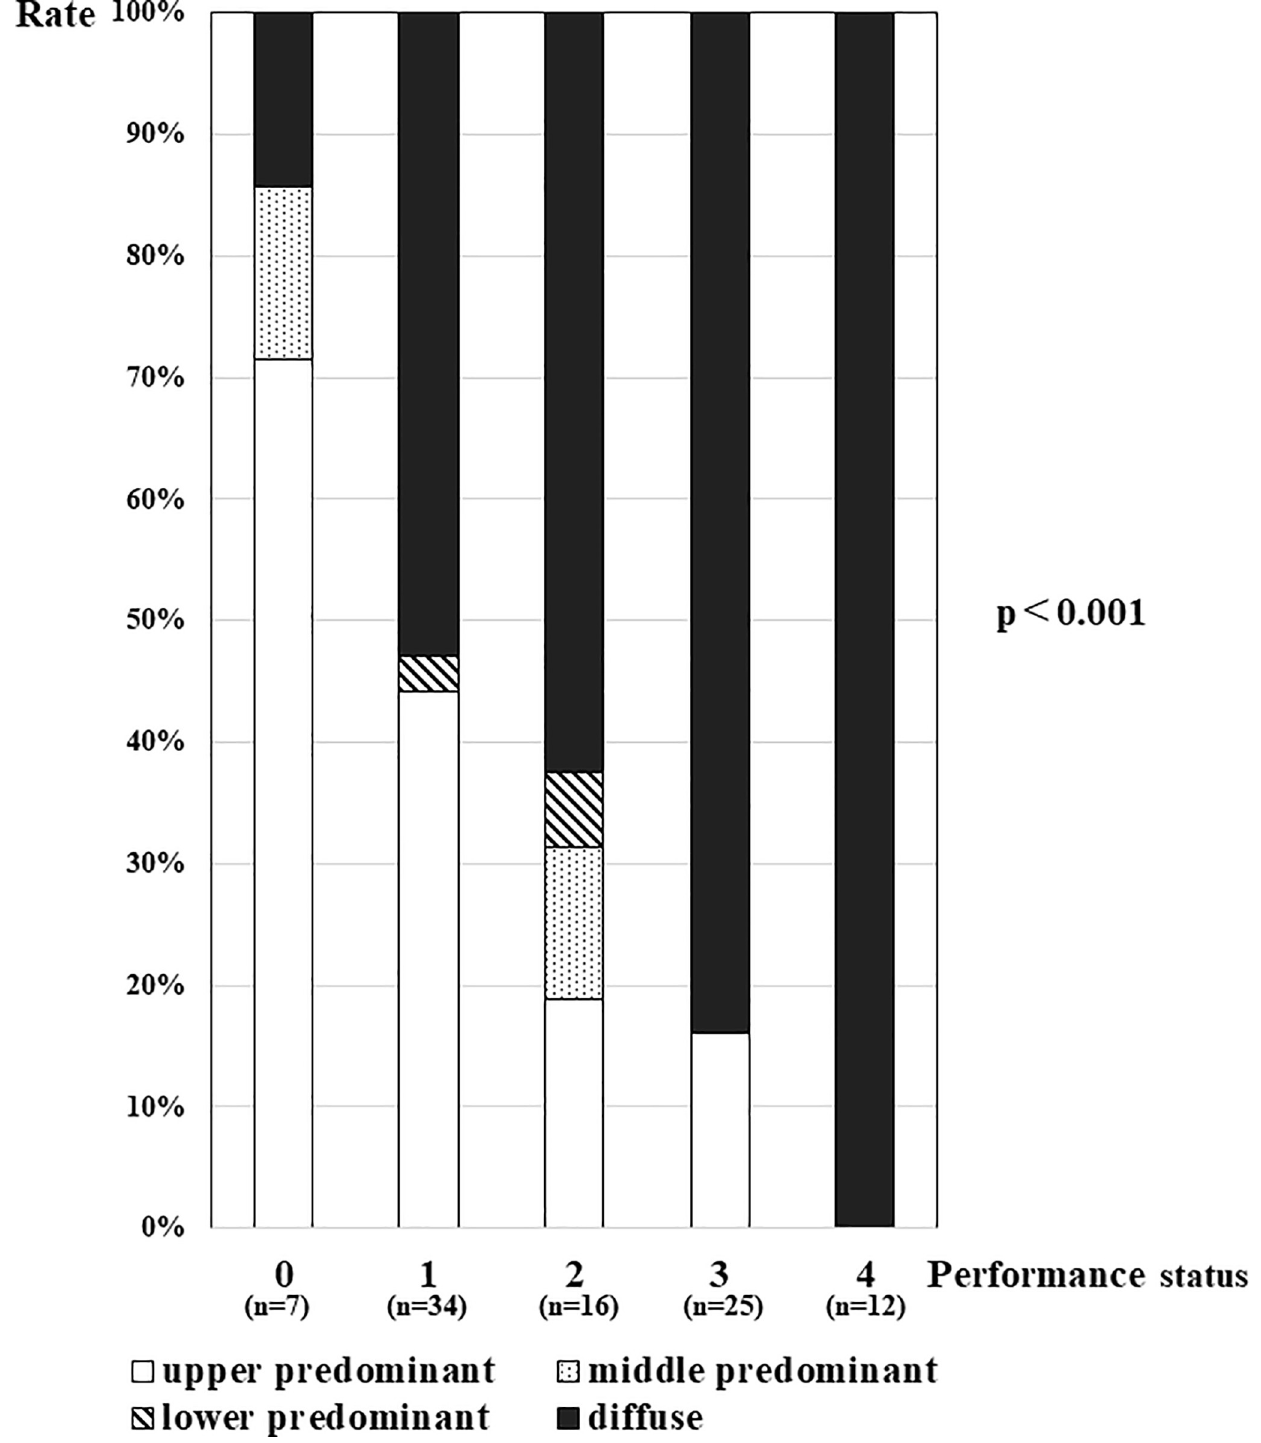
Fig 2. The relationship between performance status and lung distribution in patients with pulmonary tuberculosis. Upper predominant distributions were seen in 71% in PS0, 44% in PS1, 19% in PS2, 16% in PS3, and 0% in PS4; middle predominant distributions were seen in 14% in PS0, 0% in PS1, 13% in PS2, 0% in PS3, and 0% in PS4; lower predominant distributions were seen in 0% in PS0, 2.9% in PS1, 6.3% in PS2, 0% in PS3, and 0% in PS4; and diffuse distributions were seen in 14% in PS0, 53% in PS1, 63% in PS2, 84% in PS3, and 100% in PS4.